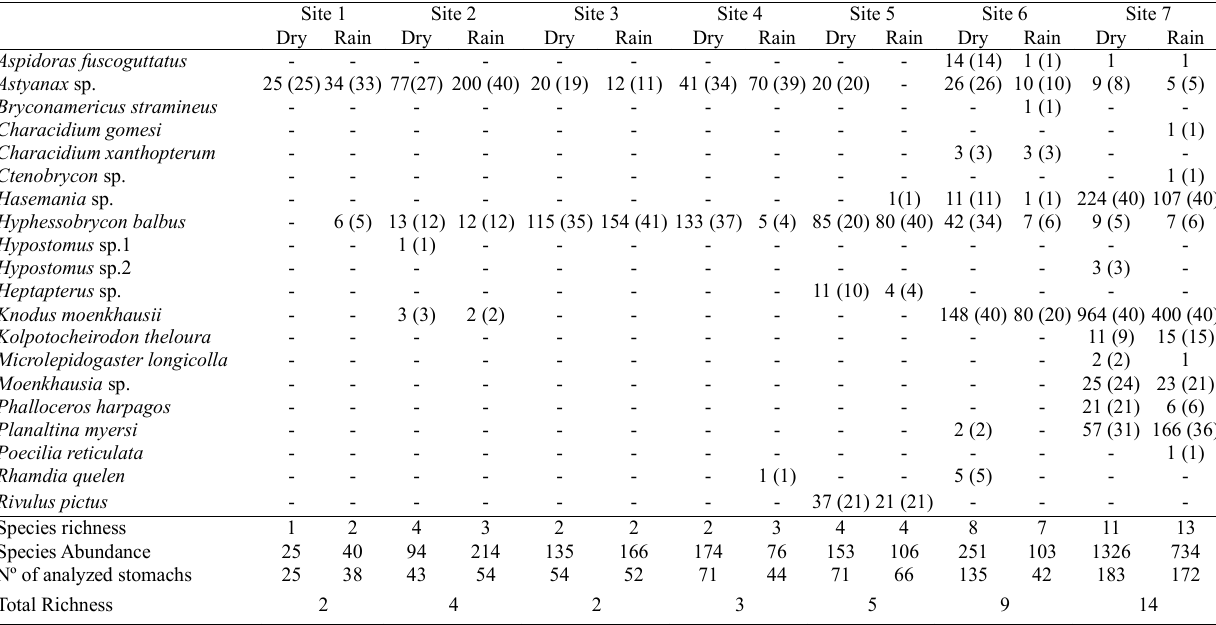
Table 3. Occurrence, abundance and number of analyzed stomachs (in parentheses) of the fish species found in the seven samples sites, in each season, at the Bananal stream basin, Paranoá Lake basin,